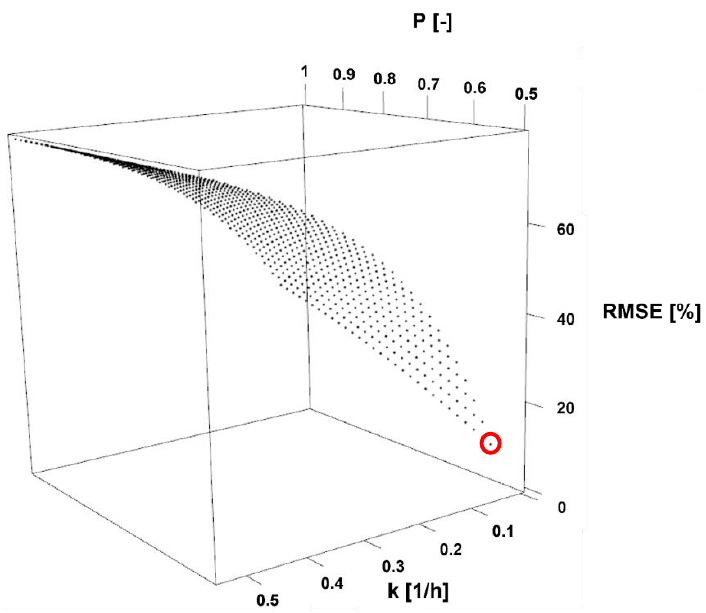
Figure 5. Surrogate model developed by Kriging for the PM2.5 decay scenario of Case D.